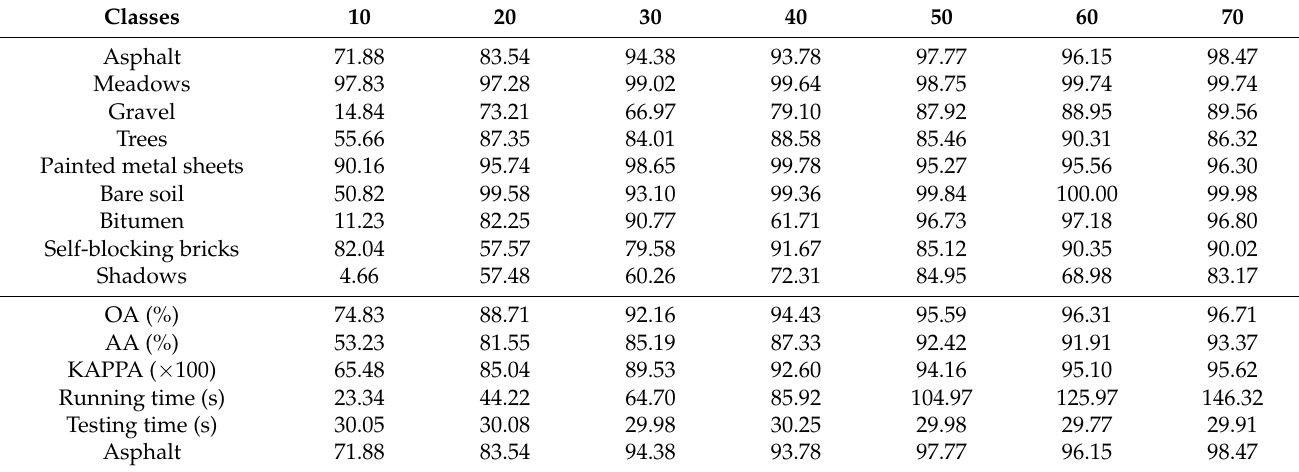
Figure 8. Accuracies and loss convergence versus epochs of the proposed MDAN model using on the WHU, SA, and PU datasets: ( a ) accuracies; ( b ) loss. According to studies in the literature, the algorithms for HSI classification are sensitive to unbalanced datasets in the predictor classes [23,38]. A model developed based on unbalanced datasets tends to result in false predictions in small samples, but the overall accuracy of the predictions is not necessarily low. Therefore, supplementary experiments are further carried out using balanced training samples, i.e., all ground objects have the same number of samples. Among all three datasets, the PU dataset is a more representative dataset, with medium spatial resolutions, lower accuracy, and a diverse set of ground scenes; thus, the PU dataset was only used for the following experiments. In this study, the training epoch was set to 100, and the range of the training samples was set to 10–70. Table 9 shows the supplementary experiment results. Table 9. Classification results of MDAN using a balanced training sample of the PU dataset.